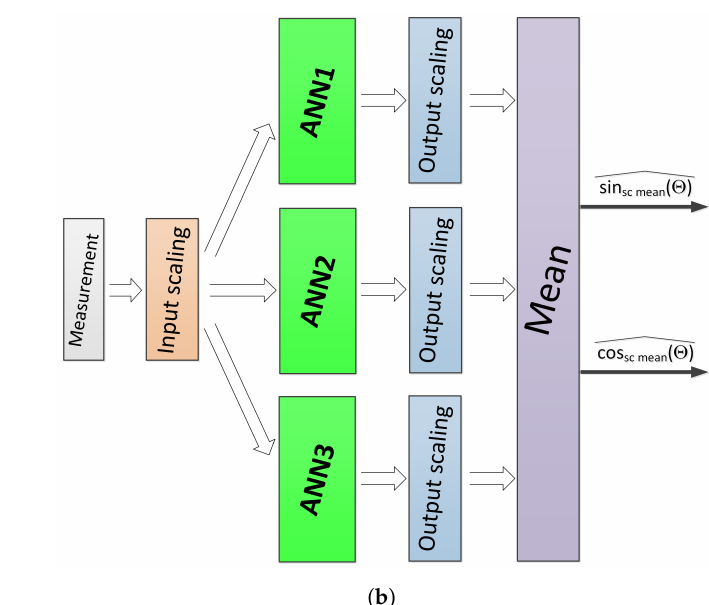
Figure 5. Visualization of the concept of estimation improvement: ( a ) Base system using a single ANN. ( b ) Modification based on using multiple ANNs. In order to get a clear picture, only three ANNs have been used here.